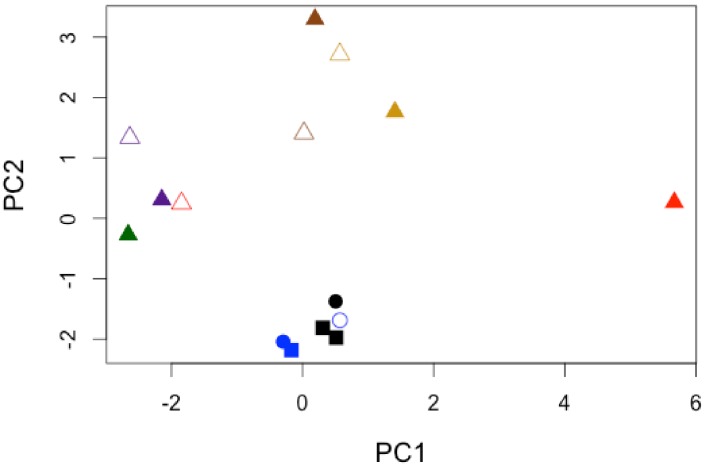
Normalised PCA of THAA composition of only the sufficiently treated samples.prcomp() function in R scale set to ‘TRUE’. Color and shape coding identical to that in Appendix 1—figure 24.